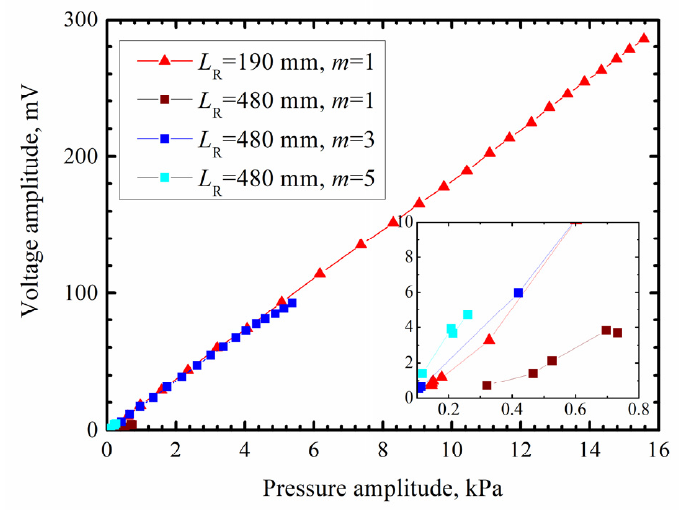
Figure 8. Output voltage amplitudes of transducer varying with the pressure amplitudes at the closed end of the cavity.